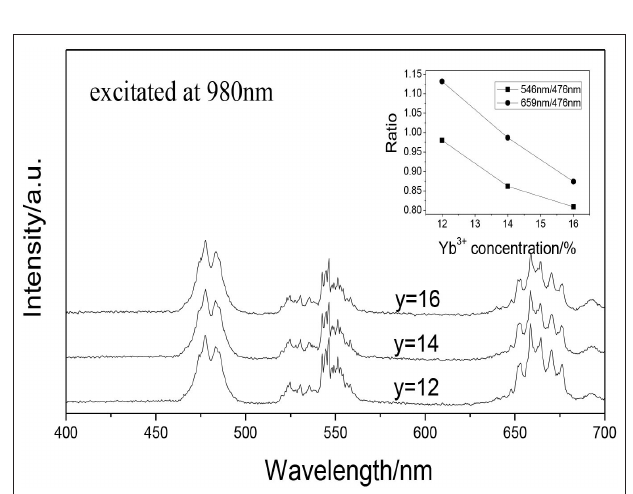
FIGURE 4 | UCPL spectra of the GdAlO 3 : 0.6%Er 3 + , y%Yb 3 + , 1%Tm 3 + phosphors (inset is the dependence of the 546 nm/476nm and 659 nm/476nm intensity ratio on Yb 3 + concentration).